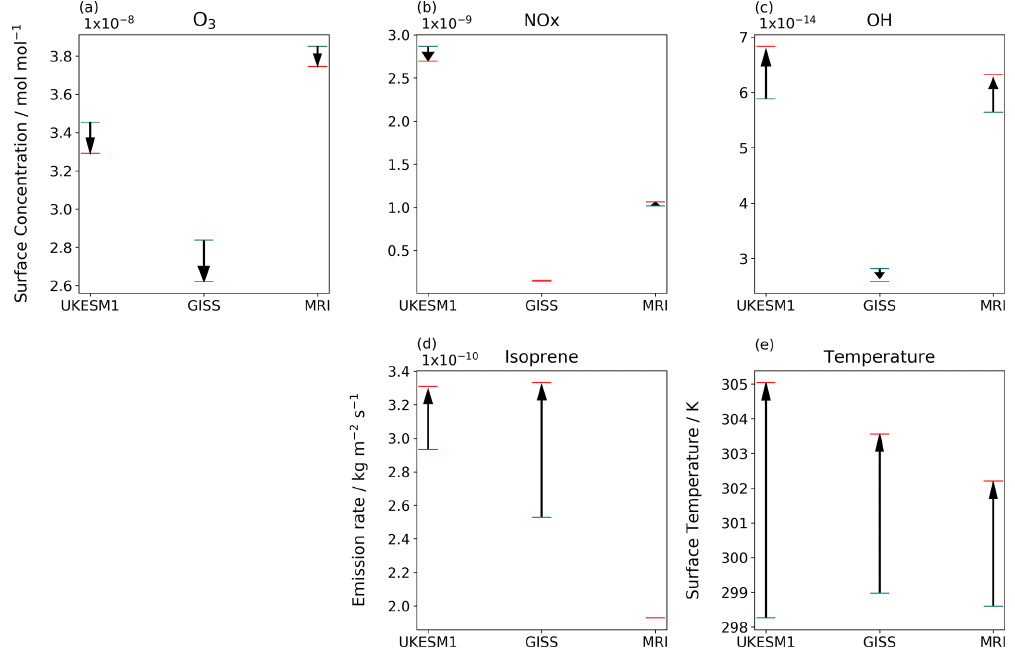
Figure 2. The change in surface concentration of (a) O 3 , (b) NO x and (c) OH, and the change in (d) isoprene emission rate and (e) surface temperature from experiment ssp370pdSST with no climate change (blue line) to experiment ssp370SST with climate change (red line) for the three climate models in this study. Variables have been averaged over the African and South American continents between 12 ◦ N–30 ◦ S for the period 2090–2100. The change due to climate change is significant at the 5% level for all variables and models except isoprene in MRI (which is prescribed so does not